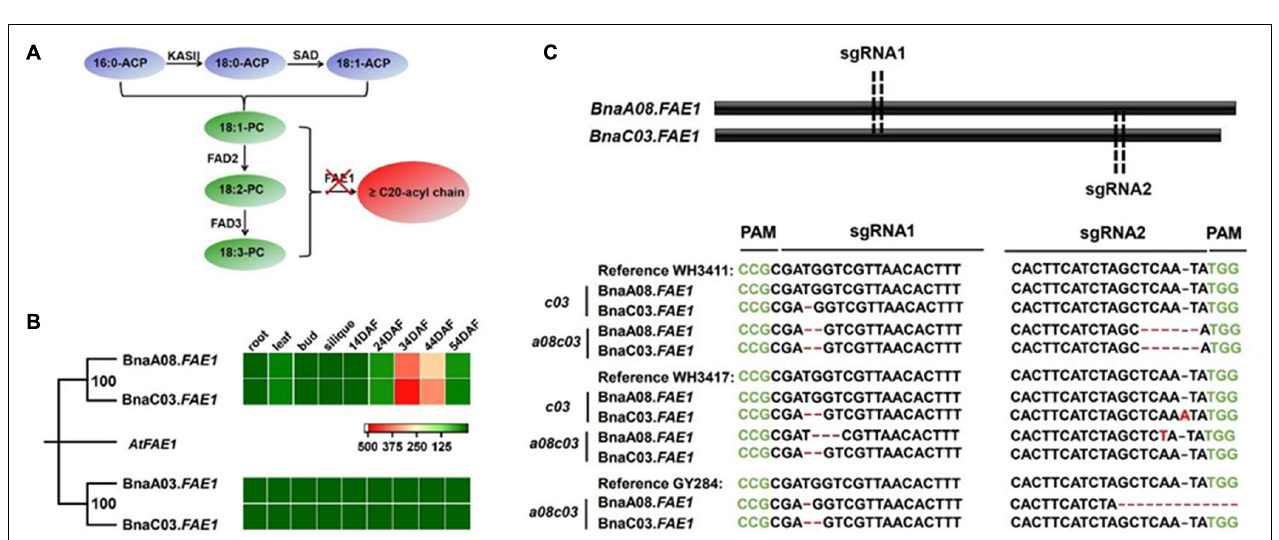
FIGURE 2 | BnaFAE1 gene analysis and mutant generation. (A) Illustration of desaturation and elongation of fatty acids. Red cross indicates mutation of FAE1 genes to block the synthesis of EA. (B) Expression pattern of BnaFAE1s in different tissues. (C) Location of CRISPR/Cas9 sgRNA-1 and sgRNA-2 targeting BnaFAE1 genes and sequencing identification of T2 homozygous mutants. PAM is indicated in green. Red “-” means deletions. Red font indicates nucleotide insertions and substitutions.